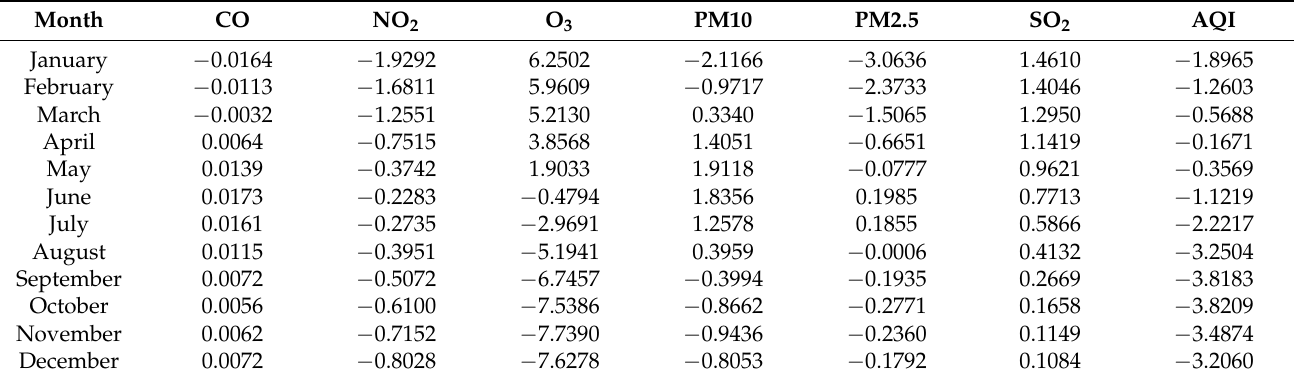
Table 2. The mean values of the last IMF in each month ( µ g/m 3 ).